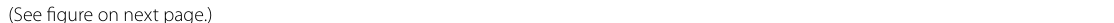
figure on next Fig. 2 S9 inhibits cancer cell growth in vitro and in vivo. A U2OS, 786-O, ACHN, HCT116, A549 and HEPG2 were treated with various concentrations of S9 for 24 h. Cell Viability was measured by CCK-8 assay. The inhibition of cell proliferation was achieved by comparing the values of each group with the control. Error bars represent SDs of at least three independent measurements. B Treatment schedule of the in vivo antitumor experiment. C Relative changes in tumor volume versus time. HCT116 (5 10 6 ) cells were injected subcutaneously into flank sites of BALB/c nude mice. Seven × days later, mice were injected 5 mg/kg, 25 mg/kg S9 or PBS by tail vein injection once every other day for six times. D Relative changes in body weight versus time. Data represent mean SD (n 4). *P < 0.05; **P < 0.01; ***P < 0.001 in comparison with PBS ± =